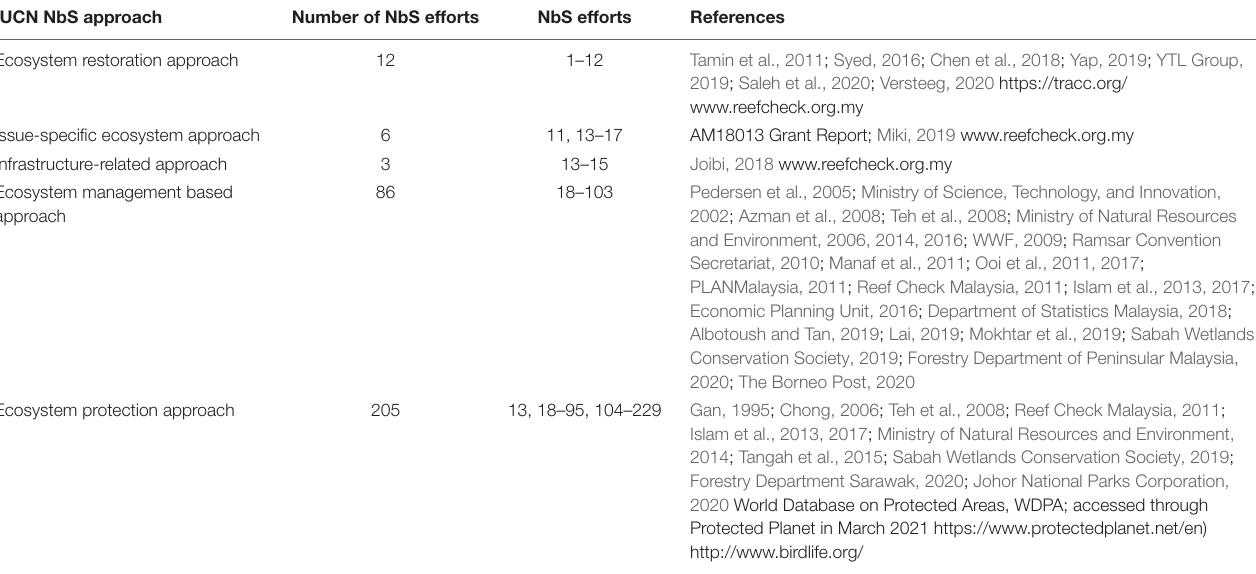
TABLE 1 | Summary of case studies categorized according to IUCN NbS approaches.